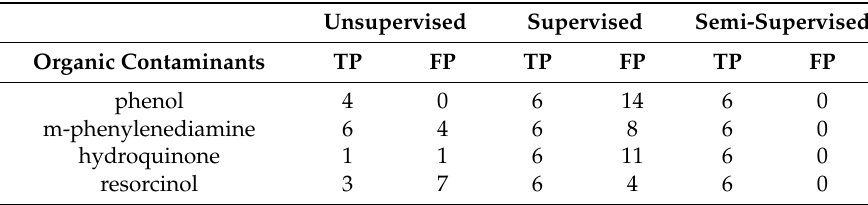
Table 4. Comparison of three methods based on the events’ level. (Each organic contaminant includes 6 events). TP indicates the number of abnormal events detected; FP indicates the number of false positive